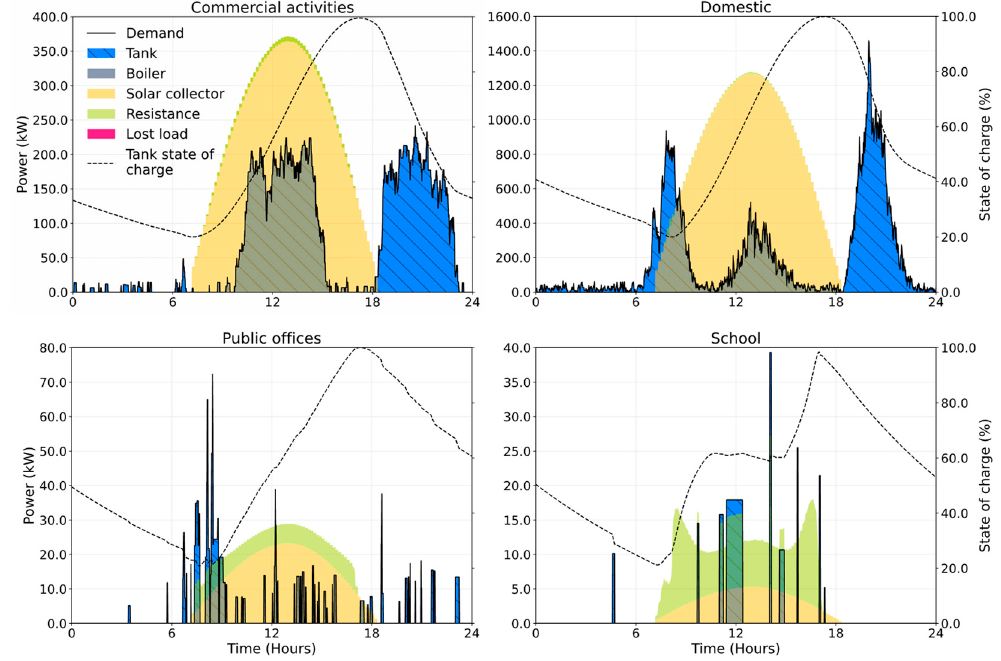
Figure 7. Example of thermal energy dispatch for representative single users for each of the four